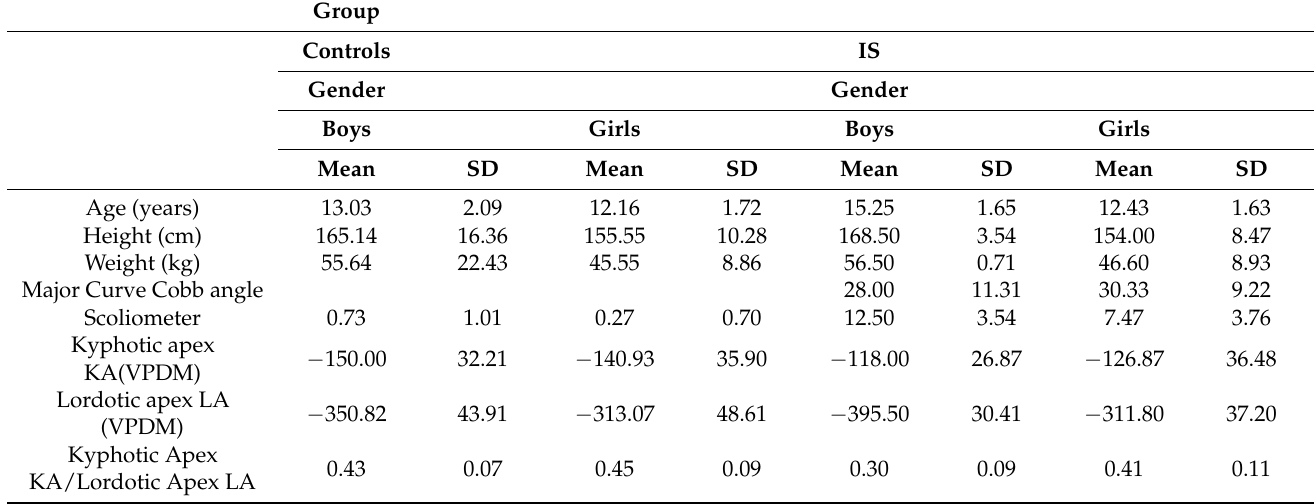
Table 1. Descriptive statistics by